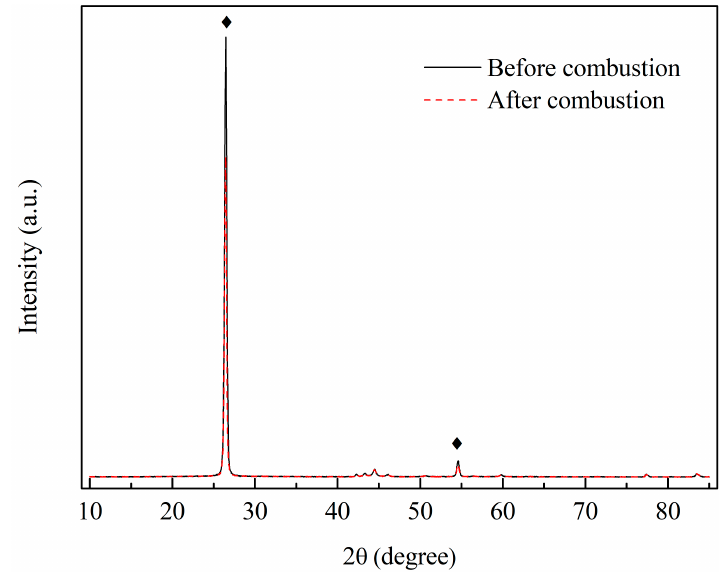
Figure 3. XRD (X-ray diffraction) patterns of graphite particles before and after combustion.